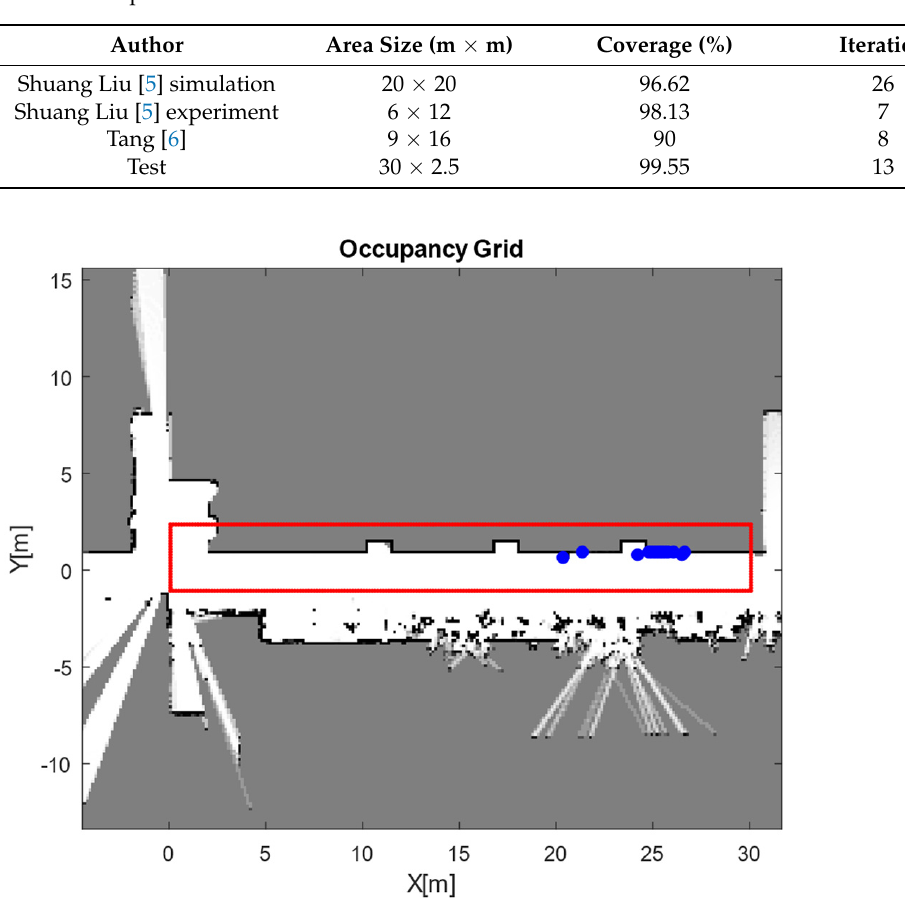
Figure 13. Generated grid map from test. 5. Conclusions Two main aspects need to be considered when designing the ASLAM method. The first aspect is to eliminate the effect of wheel drift on the result of the whole measurement. In our case, we tried to eliminate the error caused by wheel drift using the SLAM algo- rithm, which corrects the position from the odometer. The second main aspect is the cov- erage of the entire environment. The coverage of the mapped environment is solved by the method of choosing a suitable goal for the next movement of the robot. This method proposes an algorithm based on clustering potential targets and calculating their distance from the measuring system. Experiments have shown that the proposed algorithm has achieved an effective approach to solving ASLAM. In our case, the calculation time of a new goal was on average 0.3 s, which is not such a time-consuming process. If the robot cannot navigate to the target area or has covered the entire area, it returns to position (0, 0). The mobile robots can then explore the environment with enhanced stability and